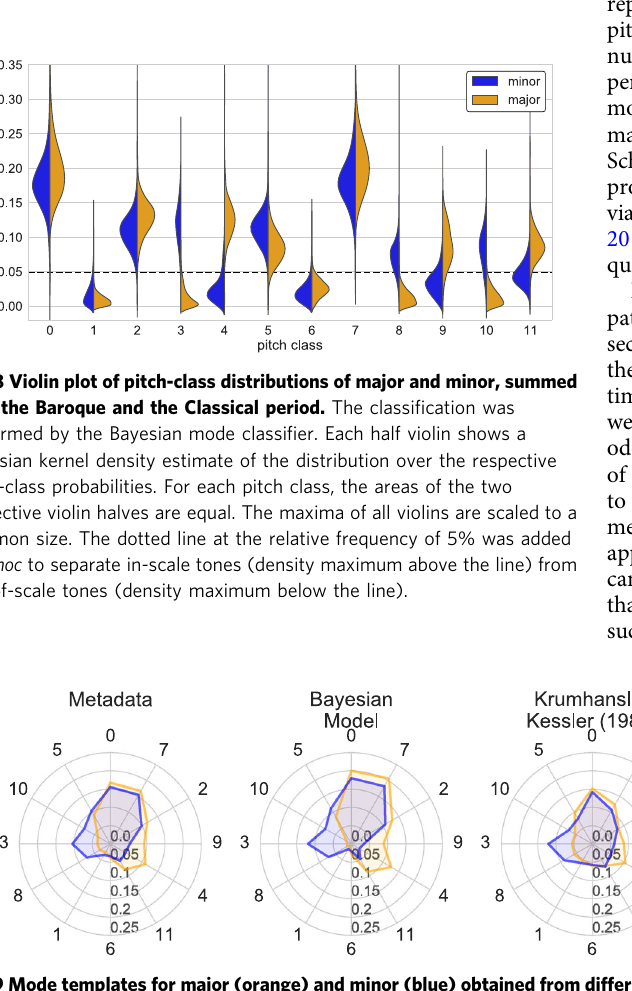
Fig. 9 Mode templates for major (orange) and minor (blue) obtained from different sources. The distance to the origin represents the probability of each pitch class. For each source, the pitch classes are ordered in the circle of fi fths so that in-scale tones and out-of-scale tones are adjacent. The corpus- generated templates (Metadata, Byesian Model, and Albrecht and Shanahan, 2013) assign much less probability mass to out-of-scale notes than the experiment-based templates (Krumhansl and Kessler, 1982 and Temperley, 2001).